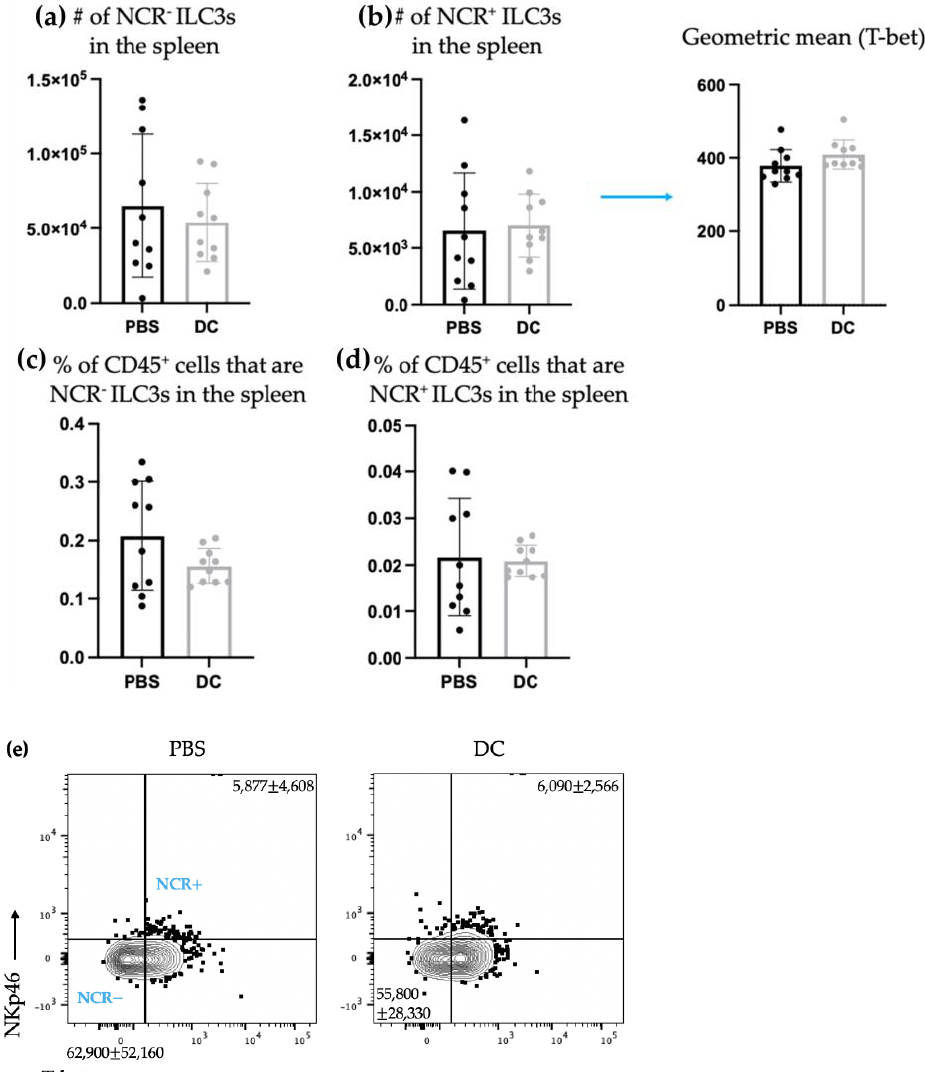
Figure 4. There was no change in the total number of splenic ILC3s after DC vaccination and challenge with B16F10 melanoma cells. Female C57BL/6 mice ( n = 10) were inoculated with DC vaccines via hind footpad injection and one week later, the mice were administered with 3 × 10 5 B16F10 cells via tail vein injection. Spleens were harvested and examined for the accumulation of ILC3 populations three days after B16F10 administration. The number of splenic ( a ) NCR − ILC3s and ( b ) NCR + ILC3s (and the geometric mean fluorescent intensity of T-bet for NCR + ILC3s) and the percentage of splenic CD45 + cells that were ( c ) NCR − ILC3s and ( d ) NCR + ILC3s were monitored and quantified by flow cytometry. A Student’s t -test was used to determine significance between the populations in the control mice treated with phosphate-buffered saline (PBS) and the DC-inoculated mice. The means were not significantly different. Representative dot plots show the average number of splenic ( e ) NCR − ILC3s and NCR + ILC3s. The mean and standard deviation are represented with the bar graphs and error